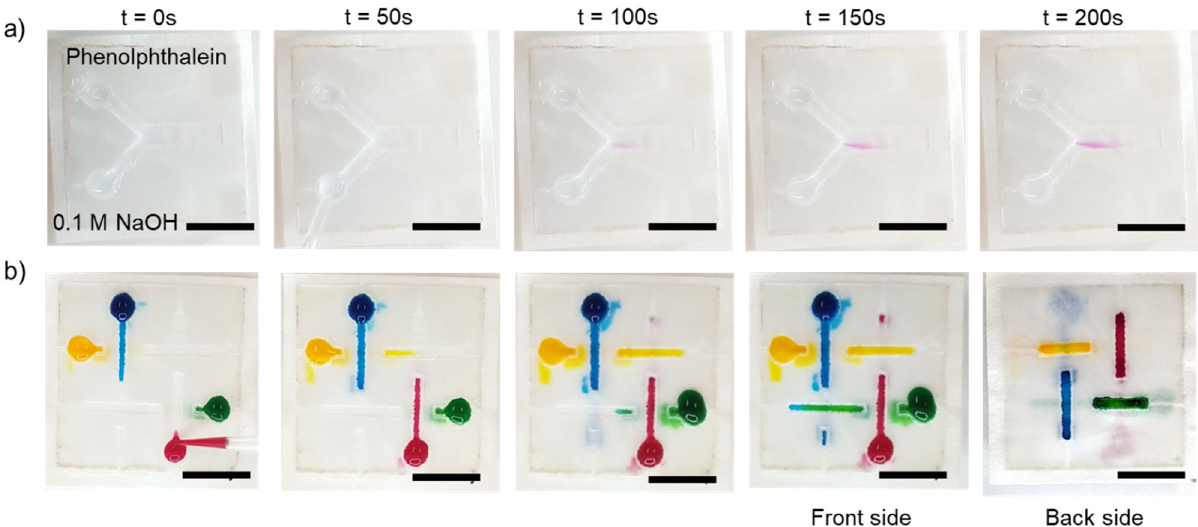
Figure 10. Analytical assay test: ( a ) diffusive mixing between 0.1 M NaOH and phenolphthalein pH indicator in the 2D analytical paper-based device; ( b ) flow in the 3D configuration paper-based device showing that there was no mixture of colour as shown in the final front and back side of the paper device. Scale bar is 5